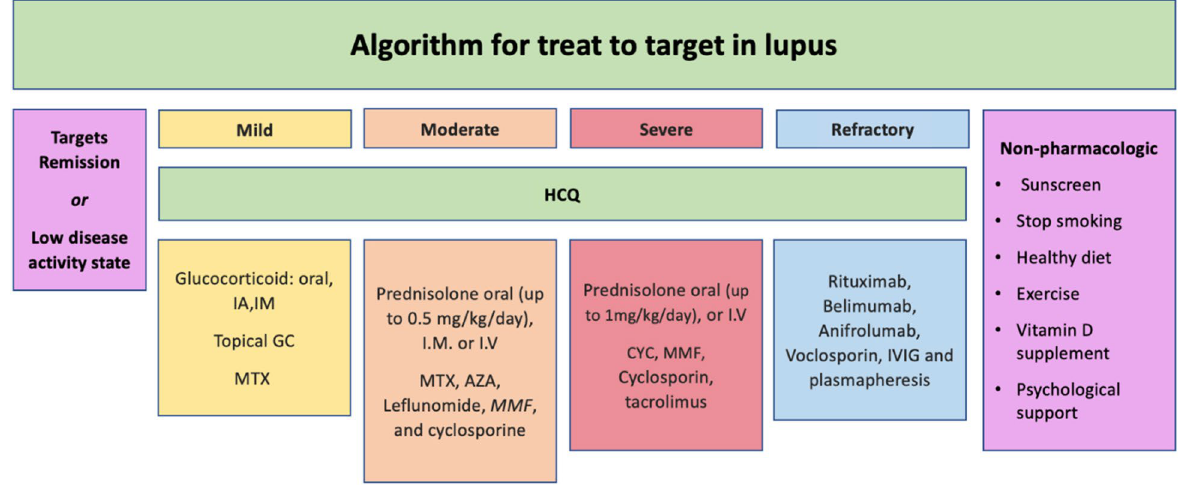
Fig. 2 Algorithm for the outlines of treat to target in lupus